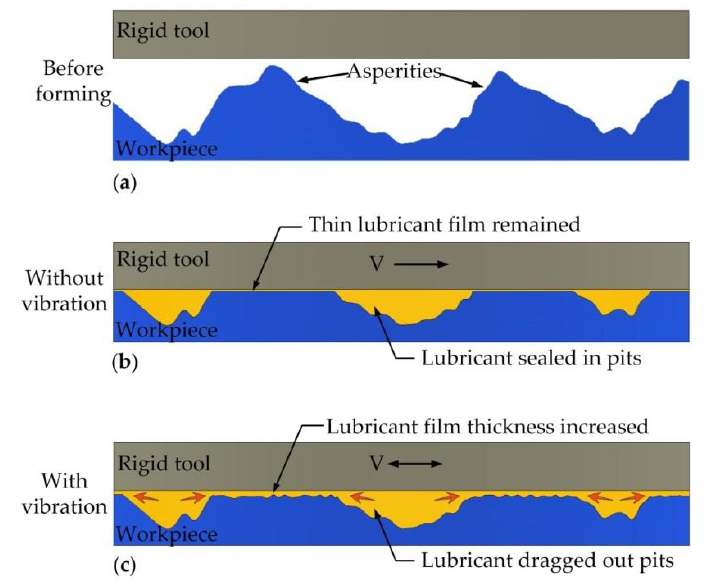
Figure 14. Comparison of lubrication during vibration-assisted forming with and without vibration: ( a ) Before forming; ( b ) Without vibration; ( c ) With vibration.